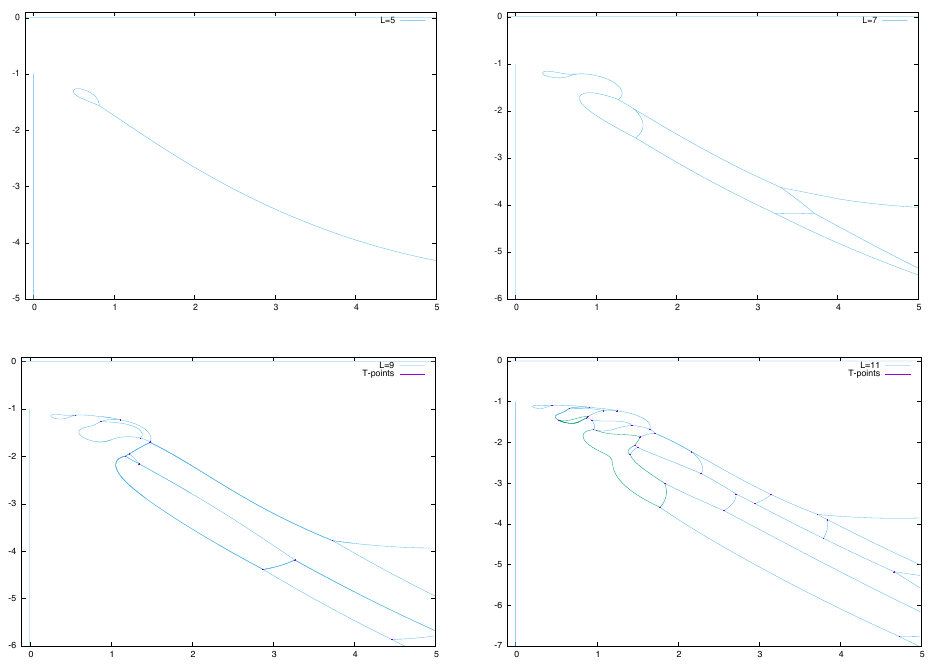
Figure 6 . Condensation curves for partition function zeros on a (2 M + 1) (cid:2) 2 N cylinder, in the limit N ! 1 (aspect ratio (cid:26) ! 1 , open channel). The panels show, in reading direction, the cases M = 2 ; 3 ; 4 ;